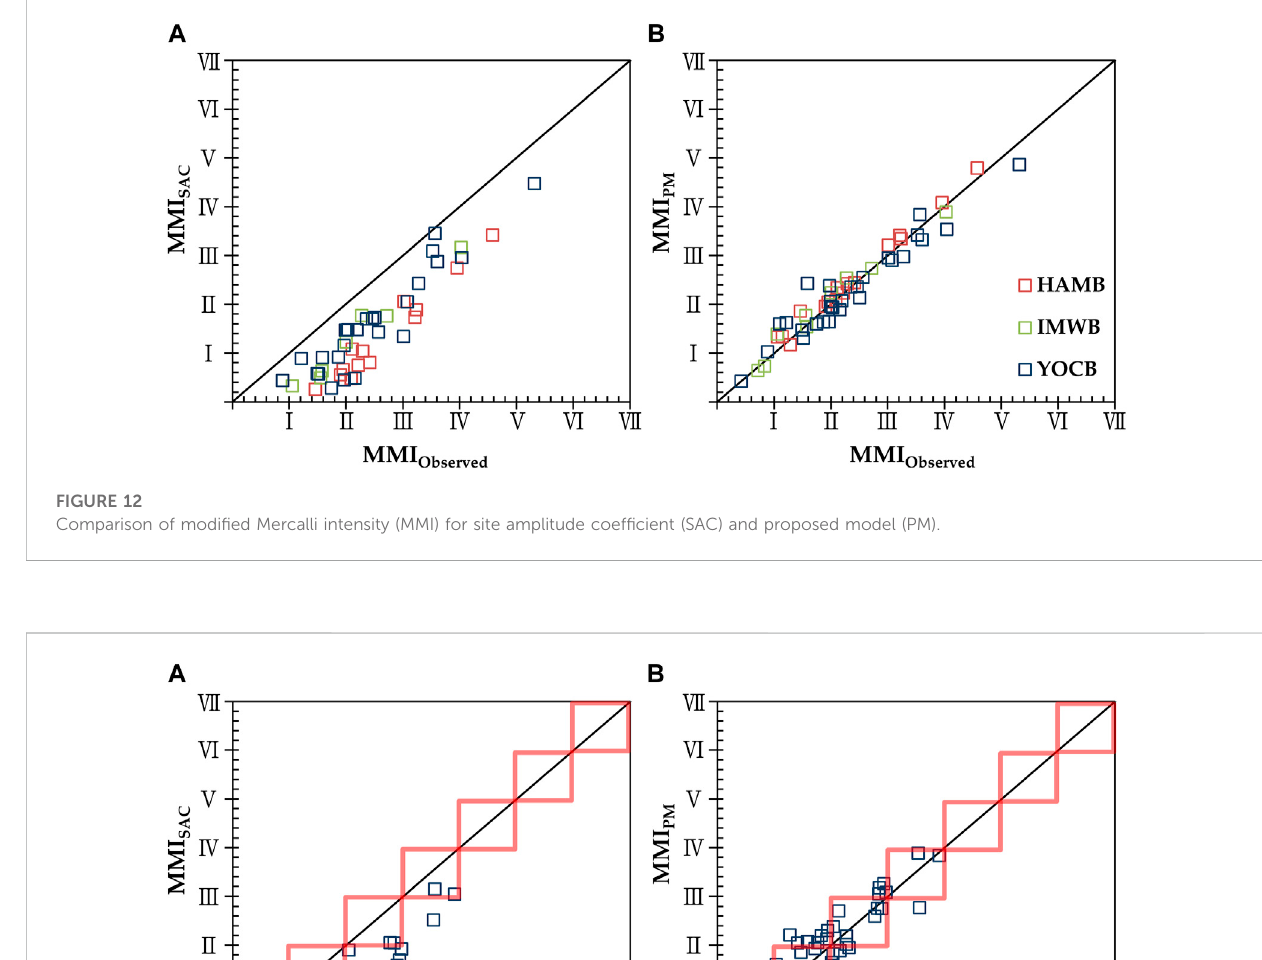
TABLE 3 Site ampli fi cation coef fi cient suggested by Borcherdt